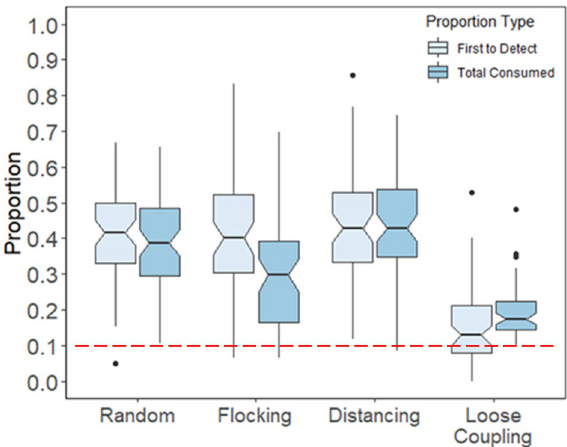
Figure 11. Finding and consuming proportions for human players as a function of movement type. The red line indicates the expected proportion to be found and consumed if human performance was no better than that of simulated agents. Proportions above the expected baseline indicate the degree to which humans outperformed simulated